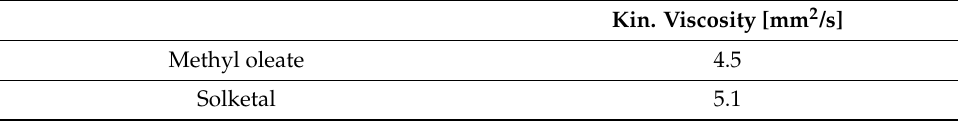
Table 1. Kinematic viscosity at 40 ◦ C for the pure